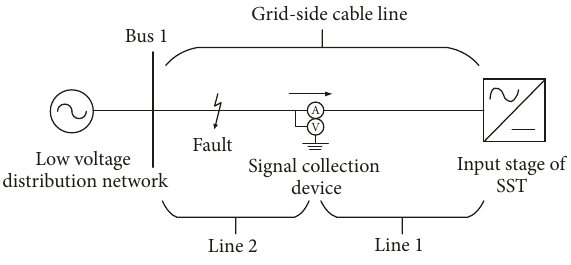
Figure 4: Schematic diagram of line fault location.